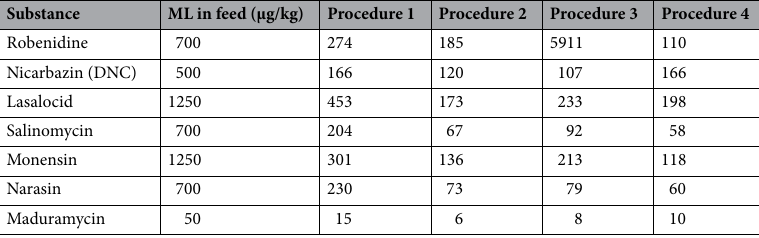
Table 7. Limits of detection (LOD) for each procedure.